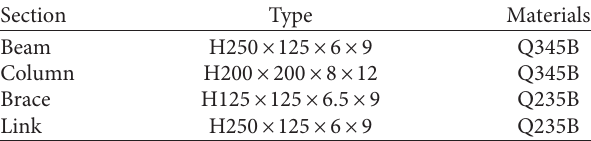
Table 1: Sections and materials of components. Section Type